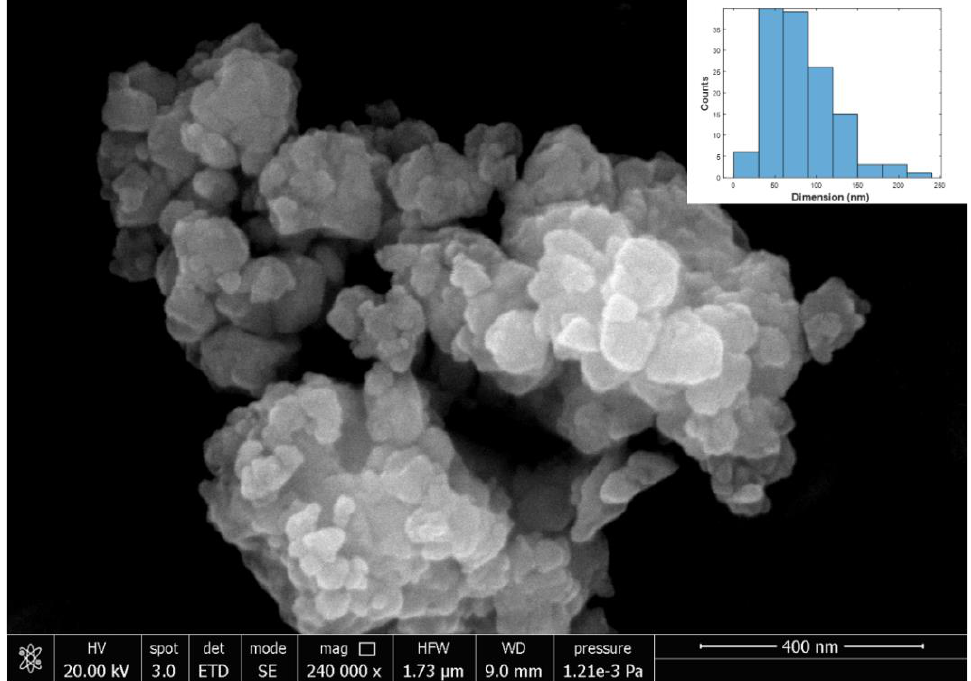
2 Sn 2 O 7 nanoparticles.